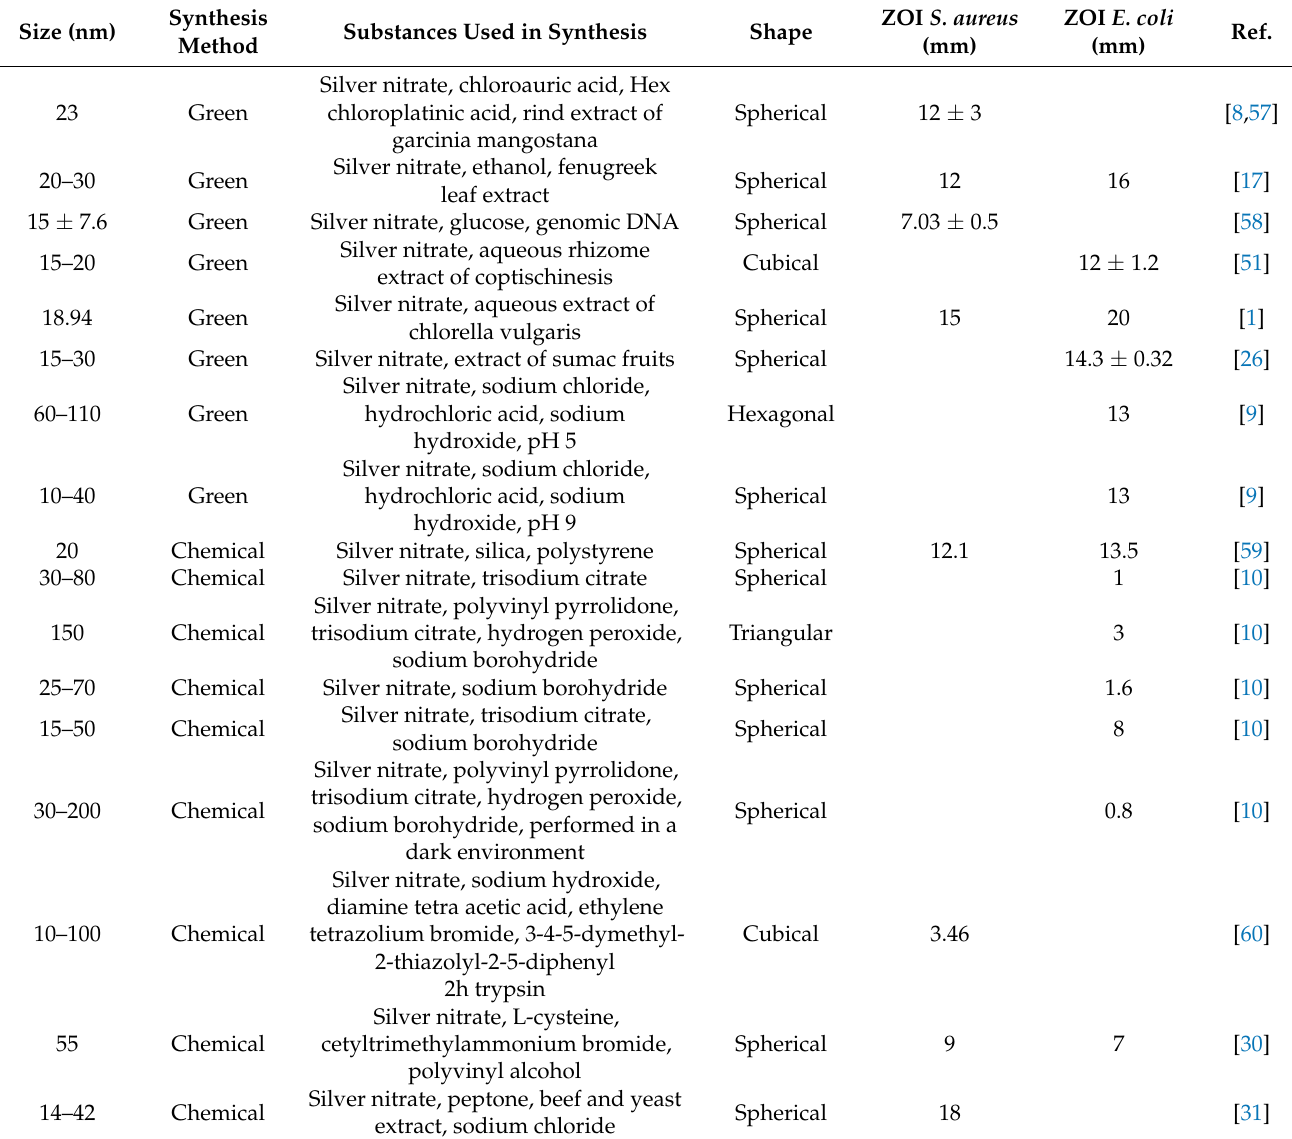
Table 4. ZOI results on S. aureus and E. coli of silver